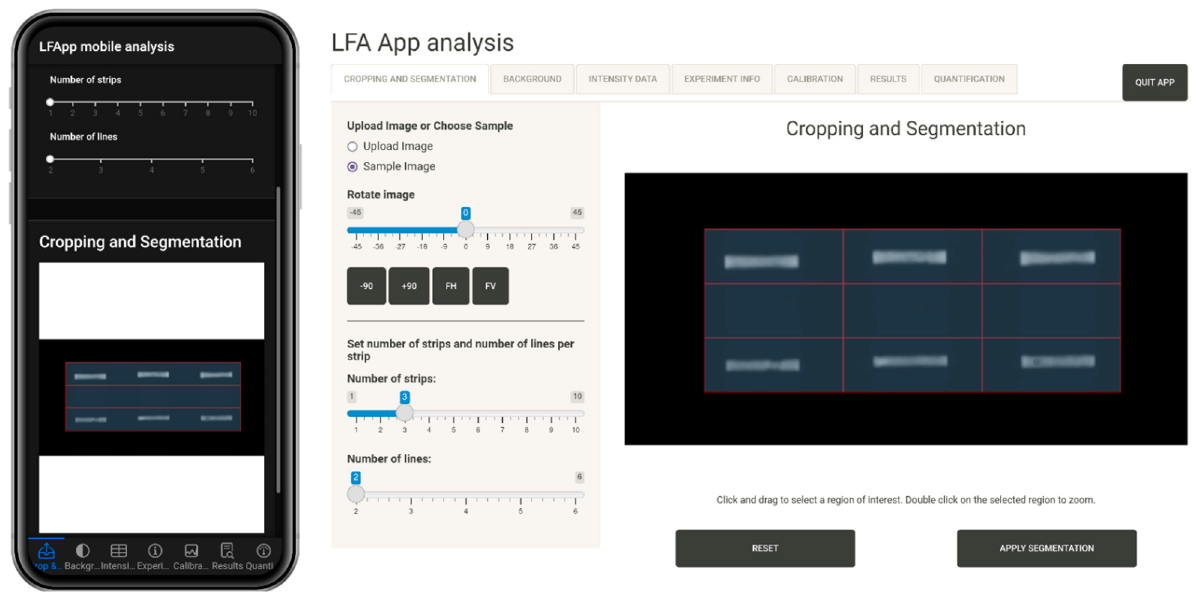
Figure 2. Image acquisition and editing functionality in the cropping and segmentation Tab of the LFA App mobile analysis ( left ) and LFA App analysis ( right ).